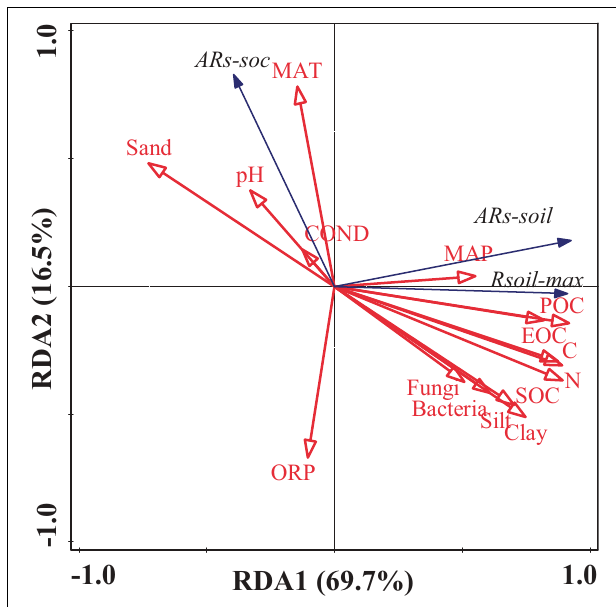
FIGURE 5 | Results of the redundancy analysis of the soil environmental factors and the soil microbial biomass. Blue arrows represent the response variables; red arrows represent the independent variables. R soil − max , soil maximum respiration rate; A Rs − soil , accumulative emission of CO 2 relative to soil mass; A Rs − SOC , accumulative emission of CO 2 relative to SOC; POC, particulate organic carbon; EOC, easily oxidizable organic carbon; SOC, soil organic carbon; N, total nitrogen; C, total carbon; pH, potential of hydrogen; OPR, oxidation–reduction potential; COND, electrical